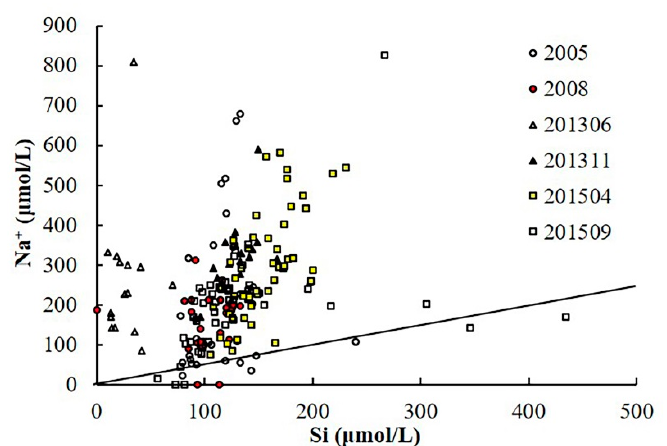
Figure 5. Diagram of dissolved Na + against Si concentrations after correction for atmospheric input and evaporite weathering for all sampling periods (except 1975 and 1985) ( μ mol/L).